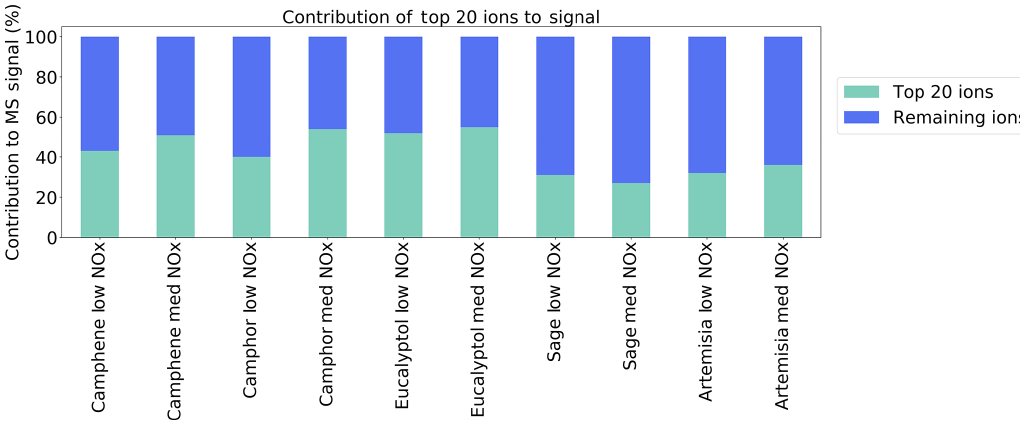
ucts are observed, with the largest contributions to the sig- (28 %), Artemisia (19 %) and eucalyptol (7